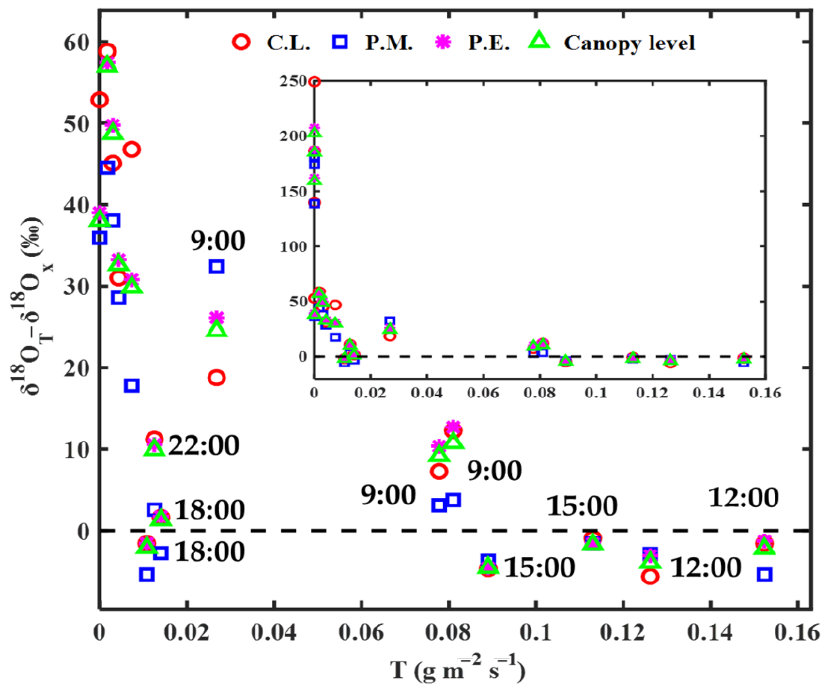
Figure 4. Dependence of the difference between transpiration δ 18 O ( δ 18 O T ) based on non-steady-state assumption and xylem water δ 18 O ( δ 18 O x ) on transpiration rate (T) with δ 18 O T − δ 18 O x < 60‰, and with all values in the inset. C.L., P.M., and P.E. indicate C. lanceolata , P. massoniana , and P. elliottii , respectively. δ 18 O T of C.L., P.E., and canopy level was calculated with δ 18 O L,e simulated by the Dongmann model, and δ 18 O T of P.M. with δ 18 O L,e simulated by the Farquhar–Cernusak